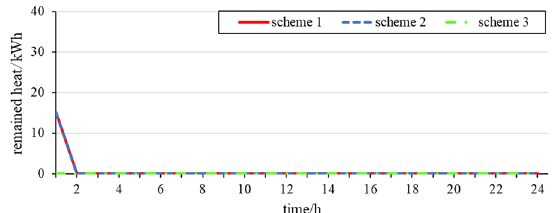
Fig. 15 Dynamic change of remaining heat of the tank in winter